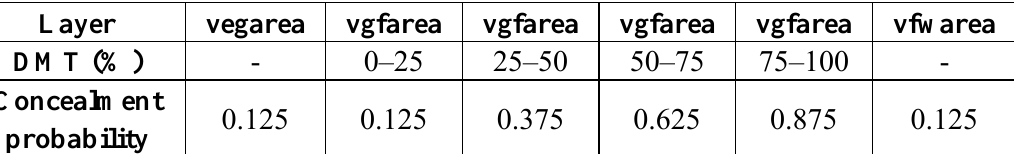
Table 2. Concealment probability parameters.